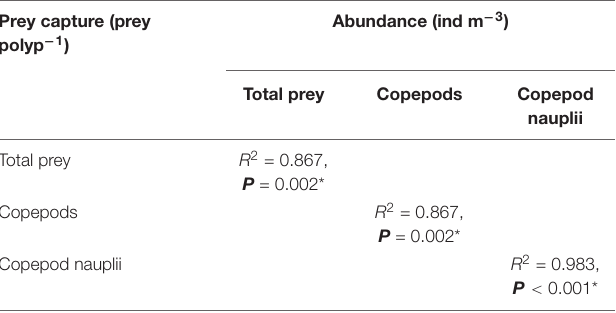
TABLE 2 | The results of Spearman correlation test for the relationship between zooplankton abundance and prey capture (prey polyp − 1 ). Prey capture (prey polyp − 1 )